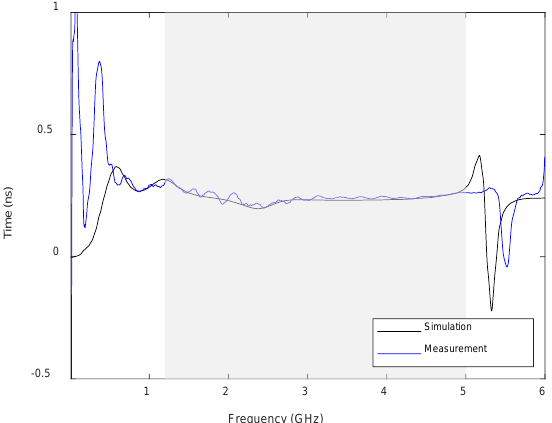
Figure 5. Measured and simulated group delay for the proposed antenna (the shadowed area indi- cates the antenna bandwidth).